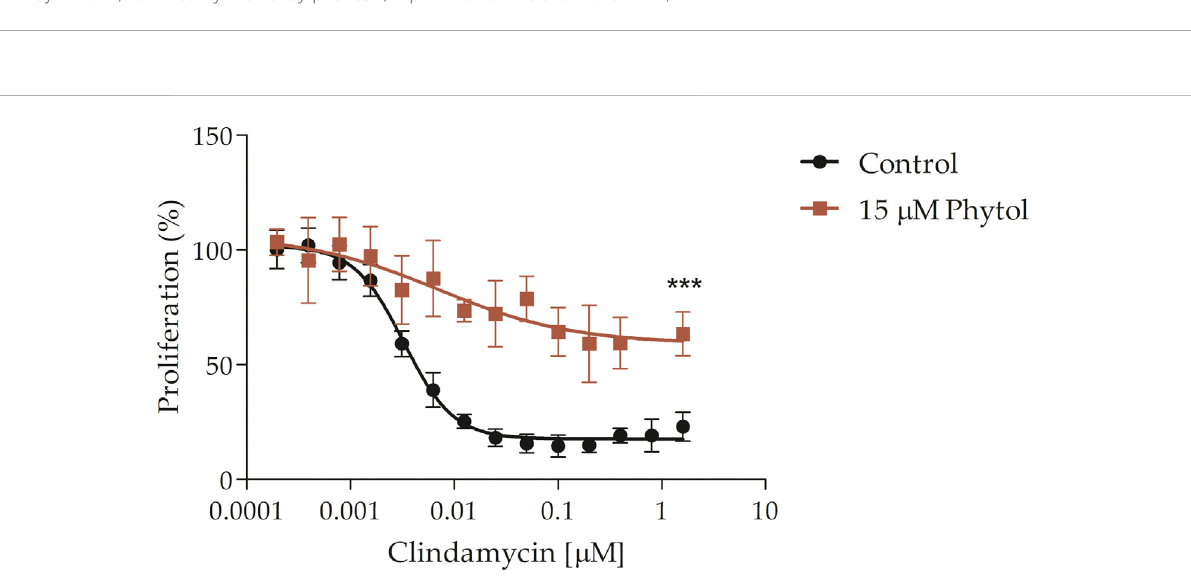
FIGURE 7 Clindamycin-rescue assay. Clindamycin dose-response effect at 72 h in the presence or absence of 15 μ M POH. Clindamycin IC 50 = 4.8 ± 1.1 nM. The value represents themean ± SD from two independent assays. Statistical analysis was performed with One Way ANOVA, followedby the Tukey posttest (*** p < 0 .005 compared to the